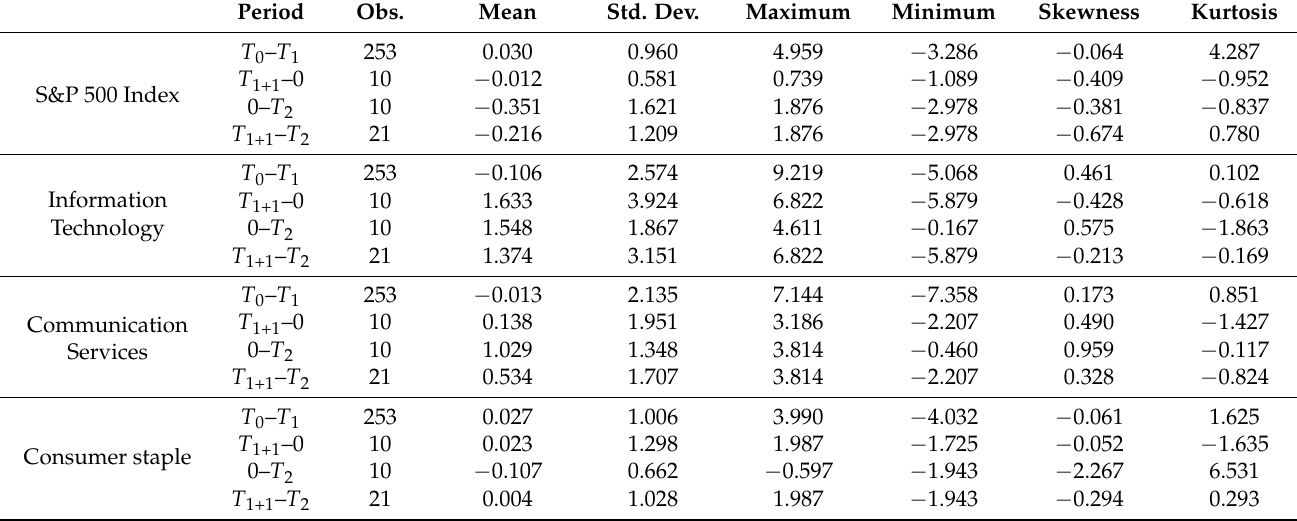
Table 1. Descriptive statistics for the daily returns (multiplied by 100) of the S&P 500 index, Information Technology, Communication Services, and Consumer Staples sectors for the ( − 10,10) event window and the “Moscow theater hostage crisis”